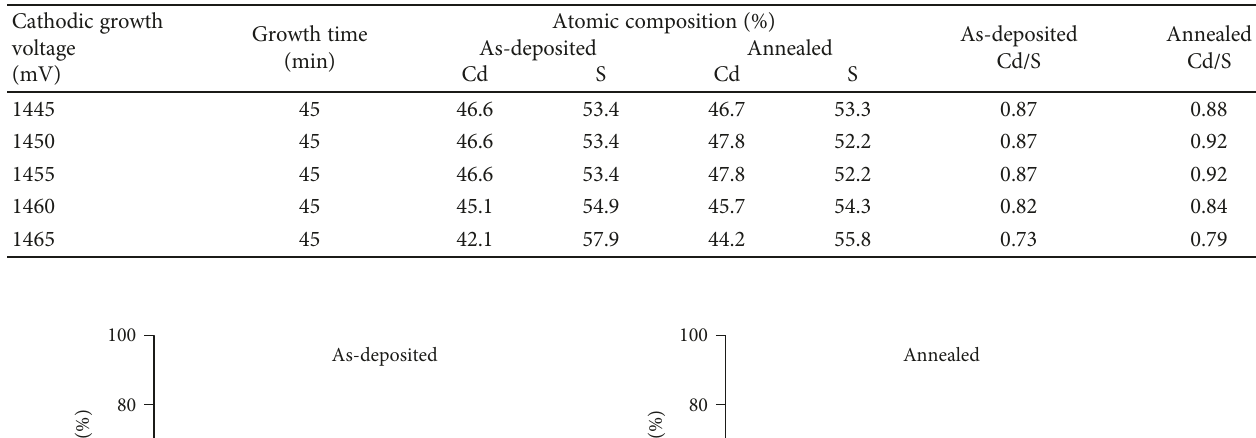
Table 5: Percentage Cd and S atomic compositions of as-deposited and annealed CdS samples grown for 45 minutes at di ff erent cathodic voltages.